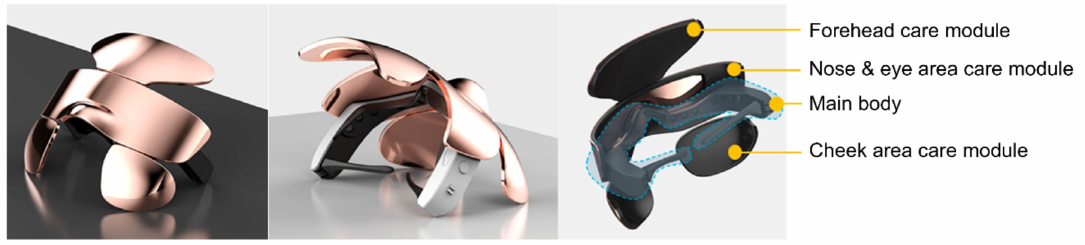
Figure 10. Final design